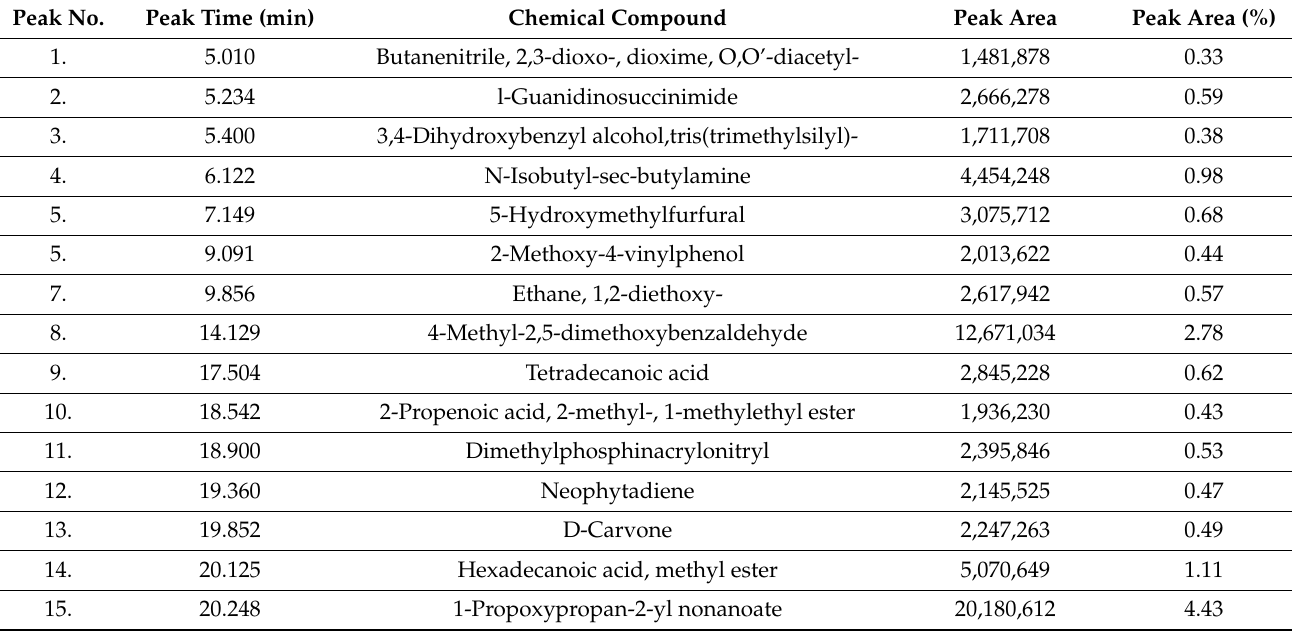
Table 2. GC-MS analysis of C. tuberculata